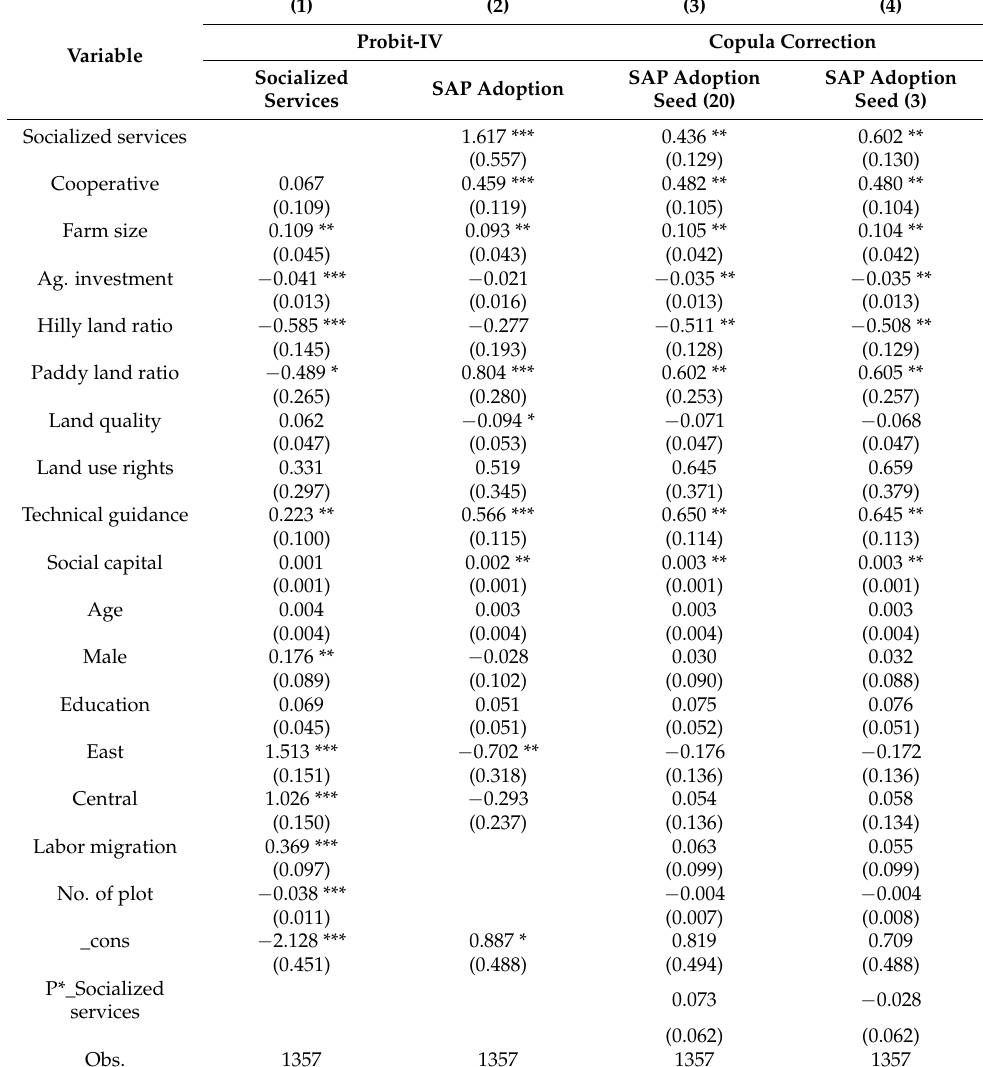
Table 6. Results of robustness